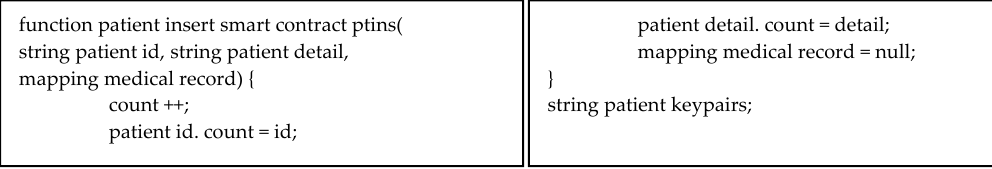
Figure 2. The patient registration phase of the proposed